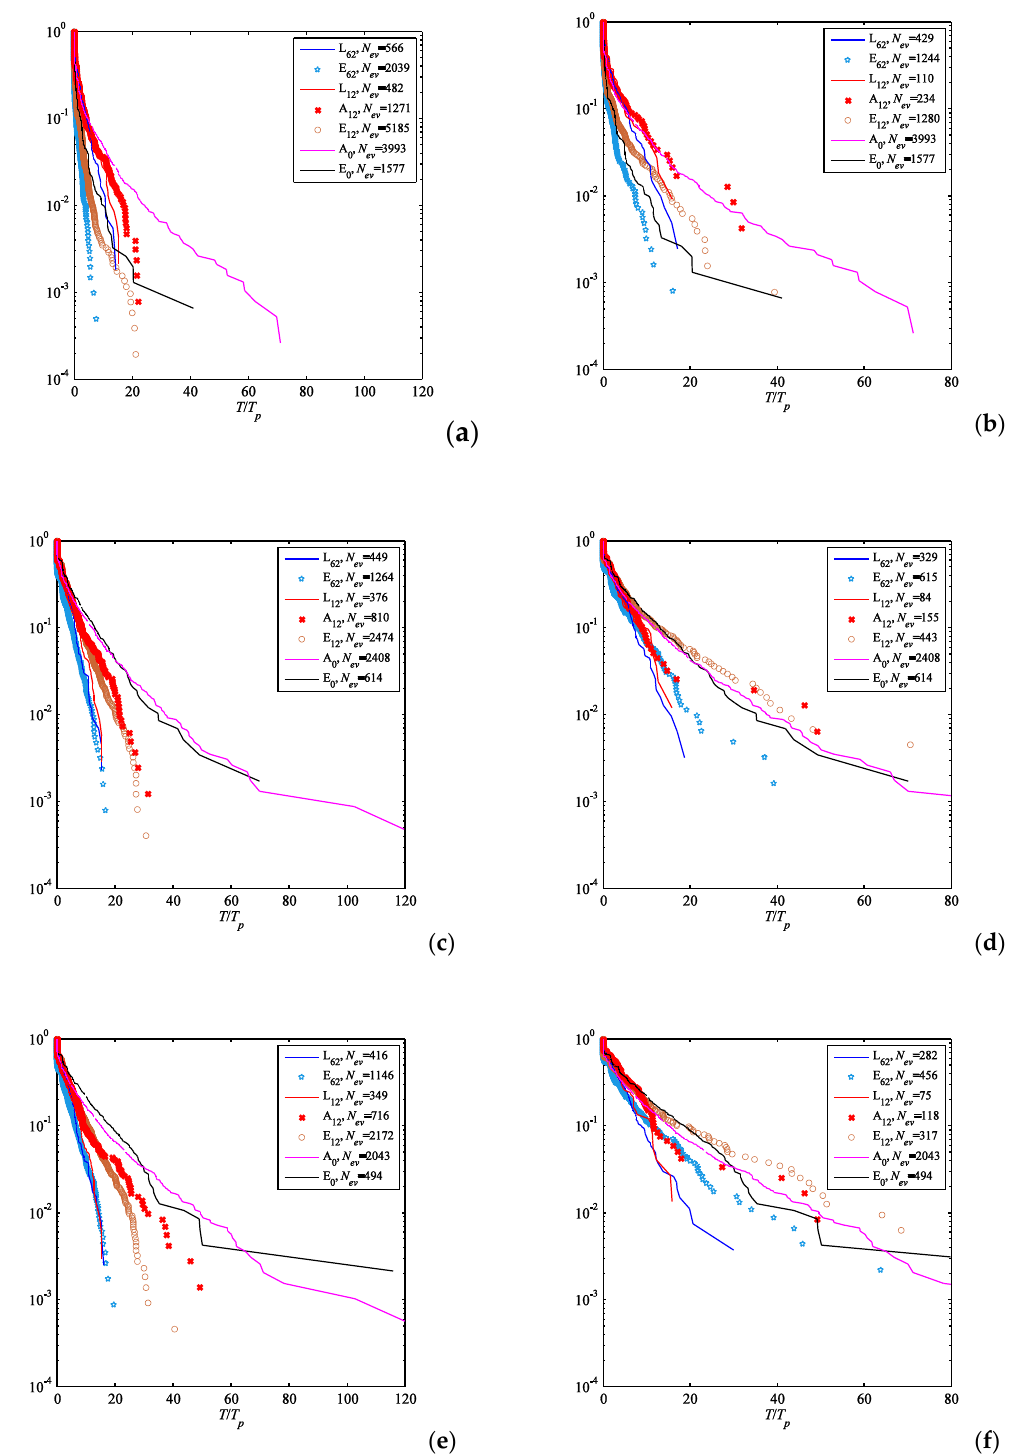
Figure 3. Exceedance probability distributions for rogue event lifetimes: ( a ) 2D rogue events, m = 1; ( b ) 3D rogue events, m = 1; ( c ) 2D rogue events, m = 2.5; ( d ) 3D rogue events, m = 2.5; ( e ) 2D rogue events, m = 4; and ( f ) 3D rogue events, m = 4.